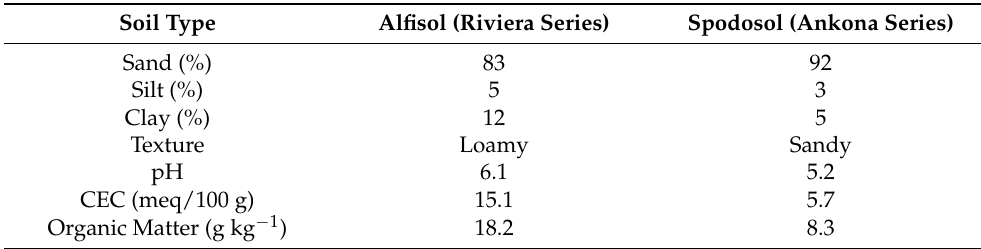
Table 1. Physio-chemical properties of soil.